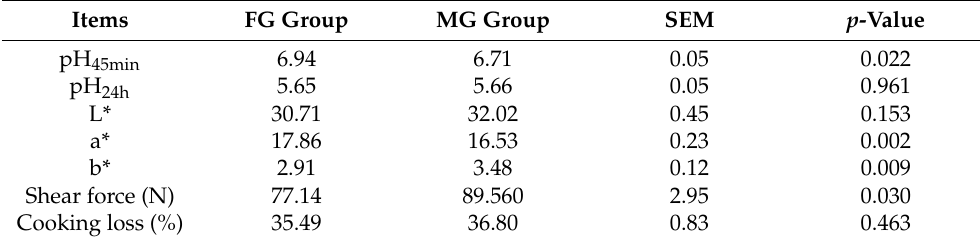
Table 6. Meat quality traits of LT muscle of goats in two